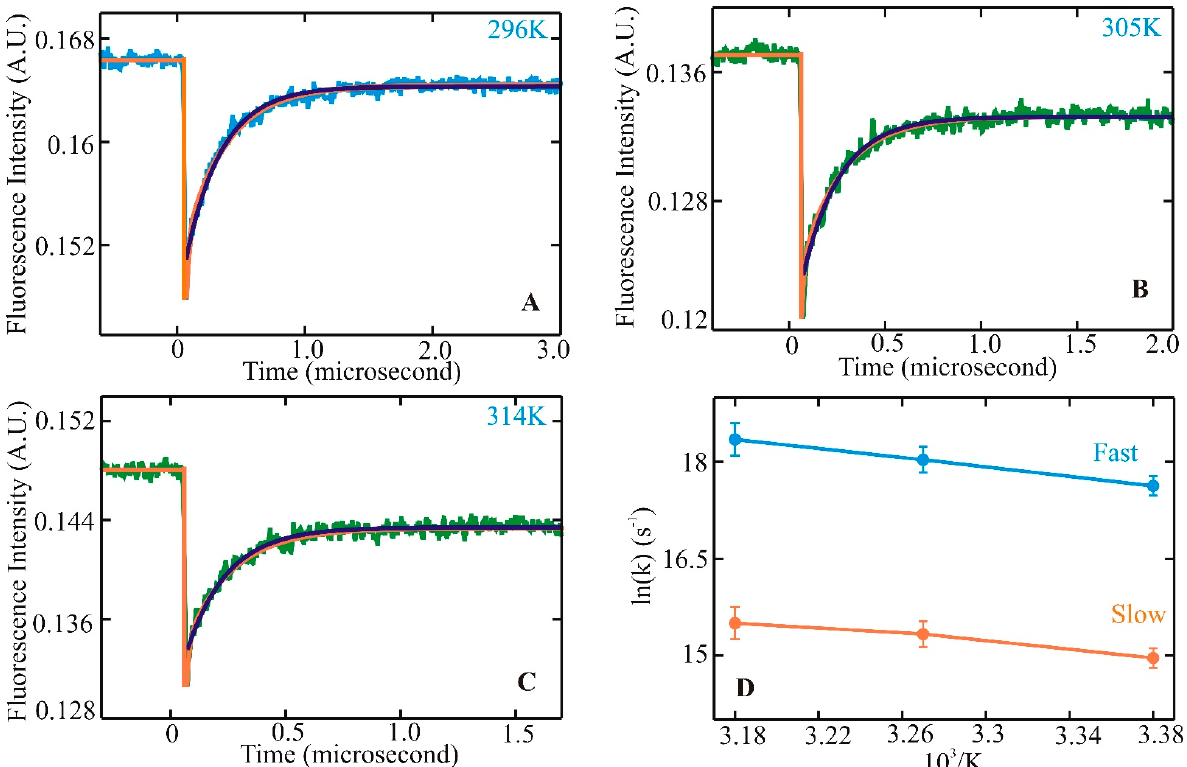
Figure 1. Helix–coil kinetics measured for WH21 0 following laser t-jumps. Kinetic traces following relaxation dynamics at final temperatures of 296 ( A ), 305 ( B ), and 314 K ( C ). Tryptophan fluorescence intensity change is plotted against the change in time. The single exponential fit to the data is shown in green. The bi-exponential fit to the measured kinetic trace is represented in orange for WH21 at 296, 305, and 314 K. The WH21 concentration in the measured sample is ~100 μ M. Kinetic rates in Arrhenius form, ln(k) vs. 1/T, are shown in ( D ), where the solid blue line represents the fast component, and the slower component is in orange [79].